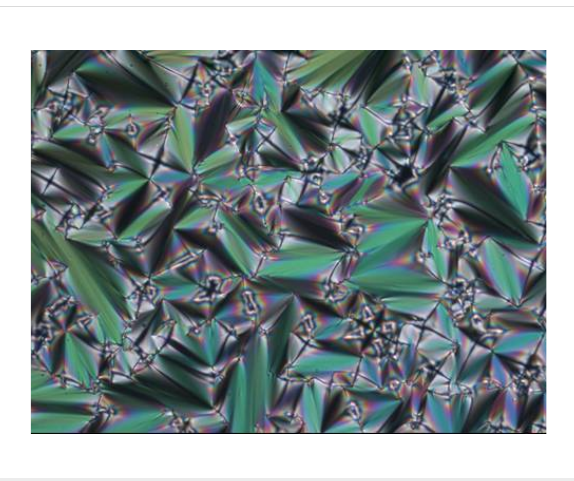
Figure 4: Fan-shaped texture of compound 4d at 45 °C upon cooling from the isotropic liquid (cooling rate 1 K/min) (magnification